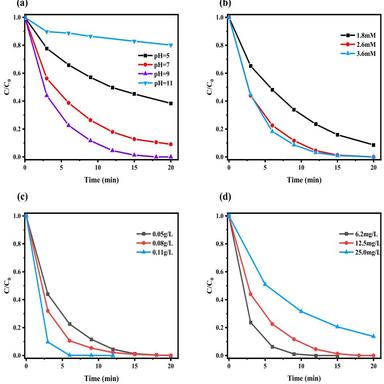
Factorial effects for the PNP degradation: (a) initial pH, (b) PMS concentration, (c) catalyst dosage, (d) PNP concentration. Experimental conditions: = 0.05 g/L, = 2.6 mM, = 12.5 mg/L, initial pH = 9, temperature = 25 ℃.